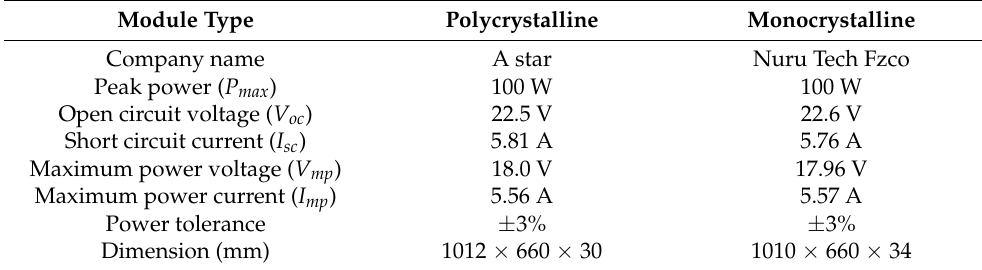
Table 1. The poly and monocrystalline modules specifications.